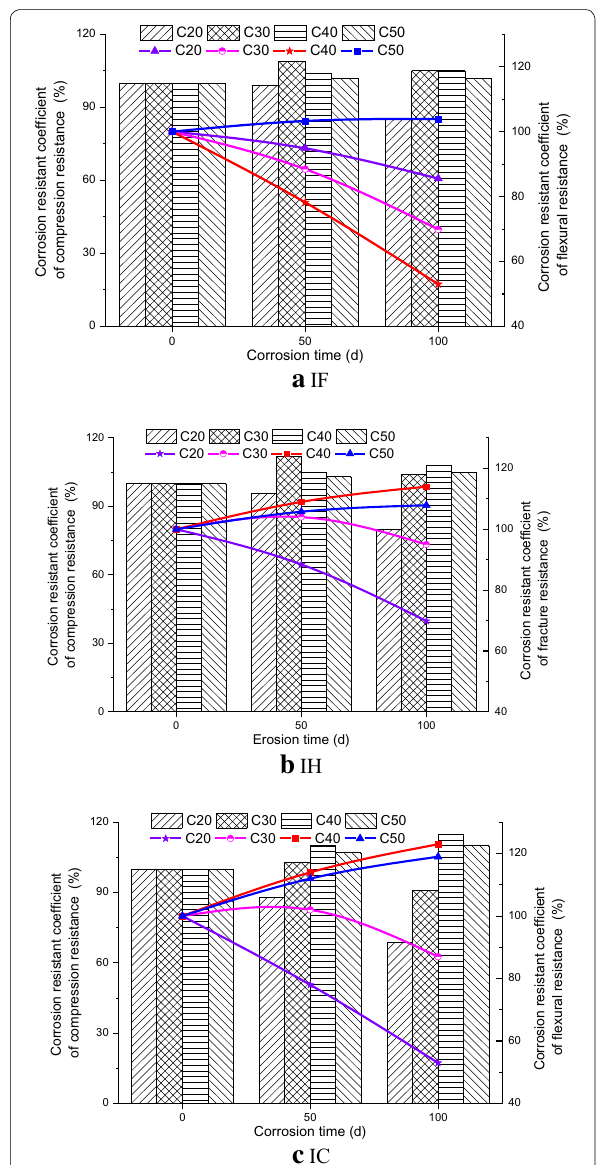
Fig. 8 Influence of concrete strength on